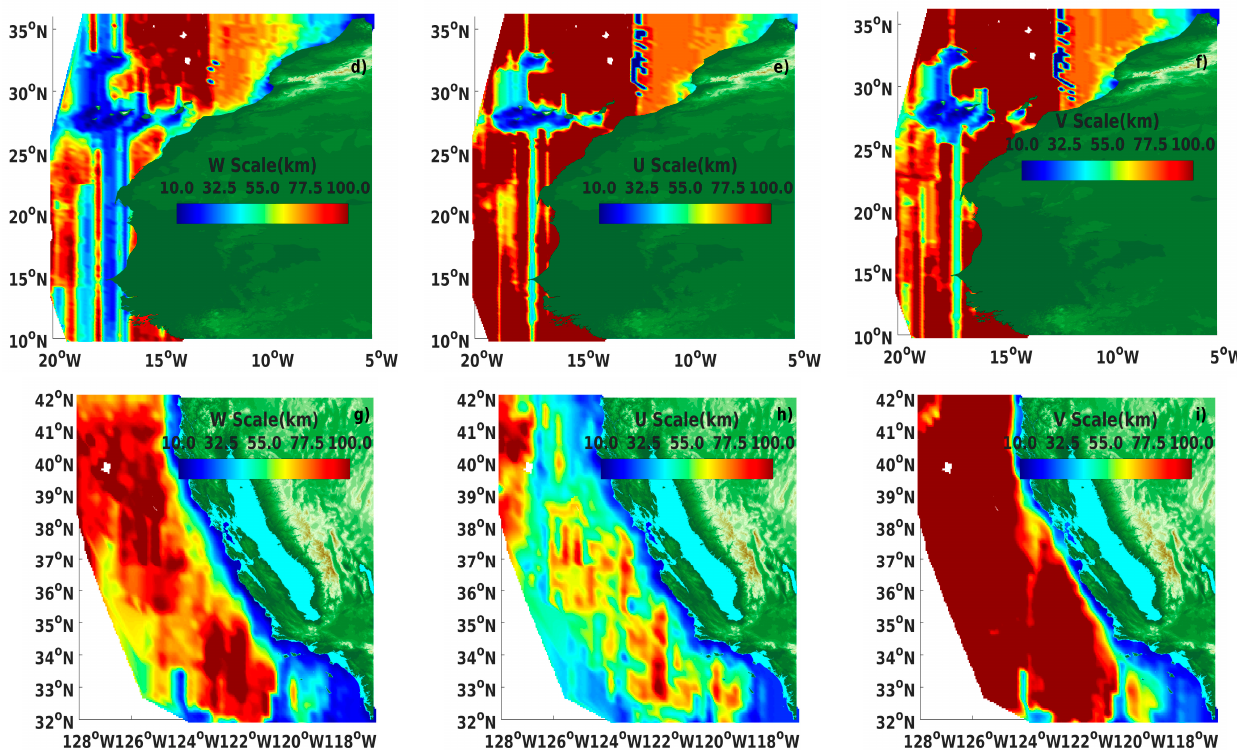
Figure 2. Spatial scales (km) of 10m wind speed ( a , d , g ), zonal wind ( b , e , h ), and meridional wind ( c , f , i ) structure functions estimated from Sentinel-1a and Sentinel-1b synthetic aperture radar (SAR) IW retrievals during 2017–2019 over Benguela (top), Canary (middle), and California (bottom) upwelling zones.